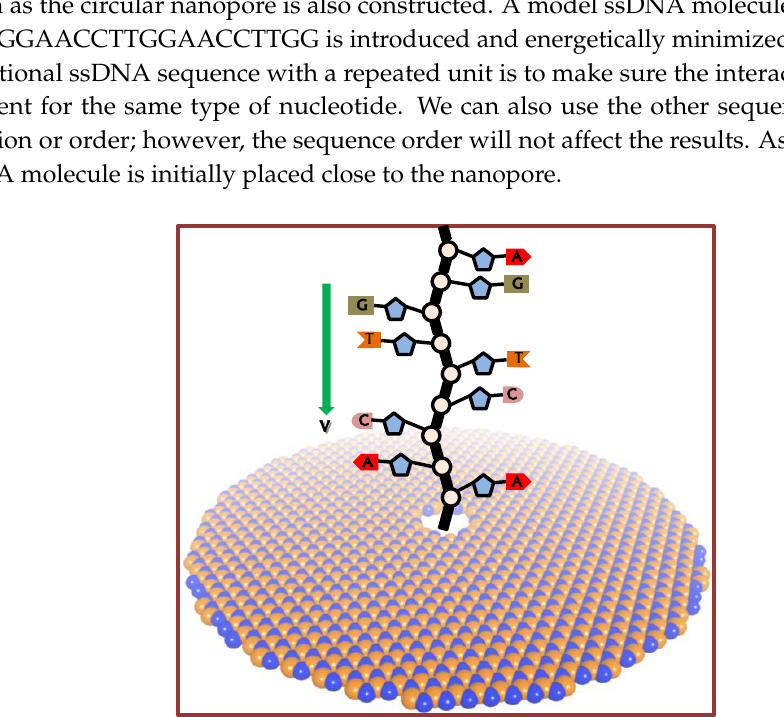
Figure 1. Scheme of single-strand DNA (ssDNA) sequencing with hexagonal boron nitride (hBN) nanopore. The ssDNA is placed right above the hBN nanopore and perpendicular to the hBN sheet. The red, orange, pink and grey areas represent the adenine (A), thymine (T), cytosine (C) and guanine (G) nucleotides separately.